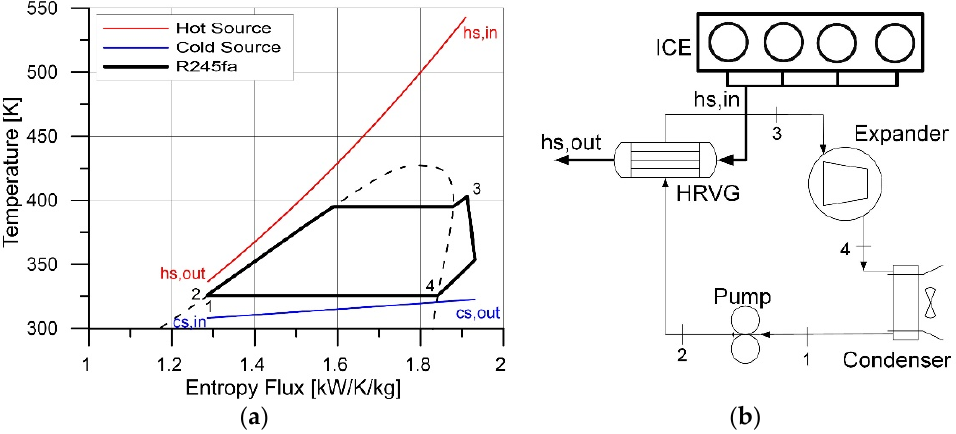
Figure 6. ( a ) base T-s diagram of an Organic Rankine Cycle bottomed to exhaust gas and using R245fa as working fluid (dashed line is the saturation curve of the fluid)); ( b ) base layout of ORC unit.